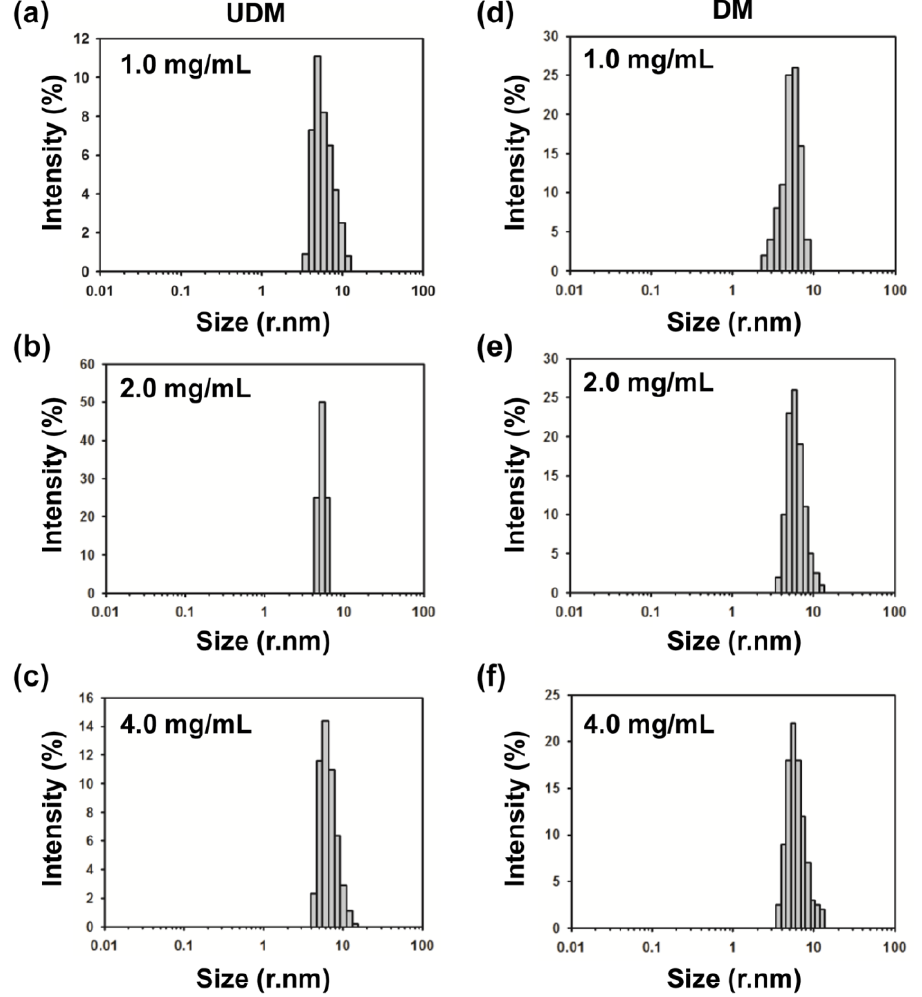
Figure A1. Oligomeric state of MdtM in UDM and DM detergents . Size distribution by intensity of 1.0 mg/mL, 2.0 mg/mL, and 4.0 mg/mL of ( a–c ) MdtM-UDM, and ( d–f ) MdtM-DM protein-detergent complex solutions as determined by dynamic light scattering